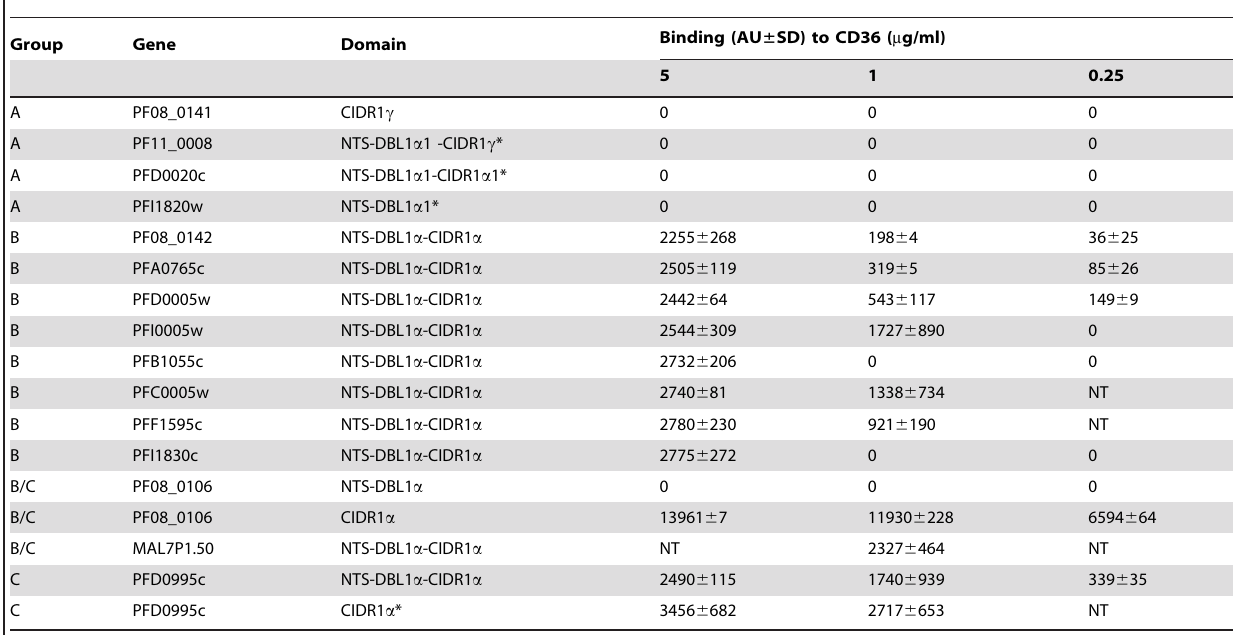
Table 1. Levels of CD36 binding to N-terminal head structures (NTS-DBL1-CIDR1) or their CIDR1 domains (CIDR1).